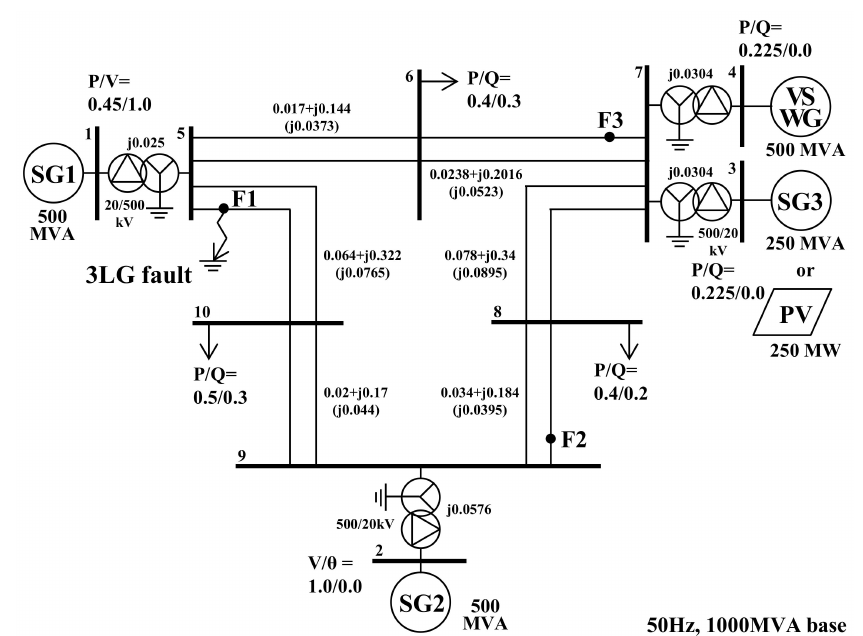
Figure 4. Power system